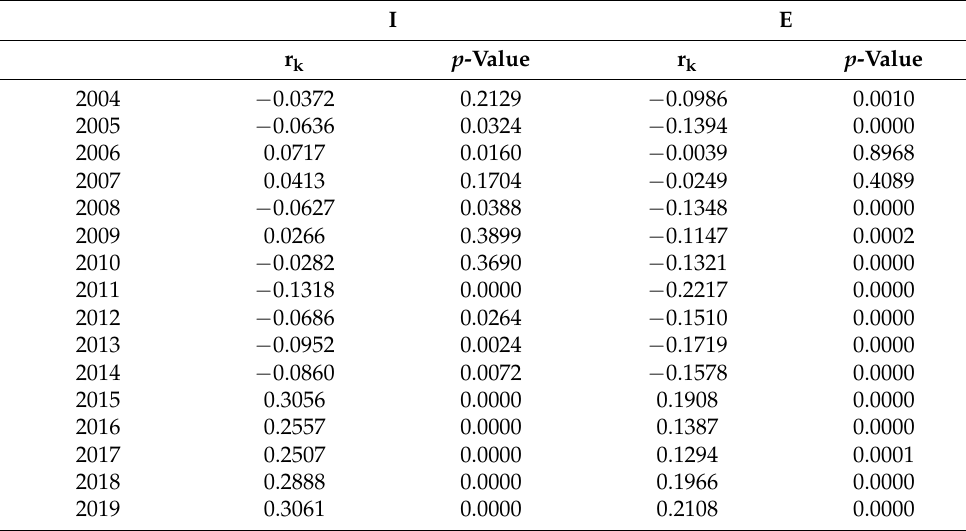
Table 2. Results of the correlation analysis of the relationship between the RCR index and in- come/expenditure in the years 2004–2019 (cooperatives).